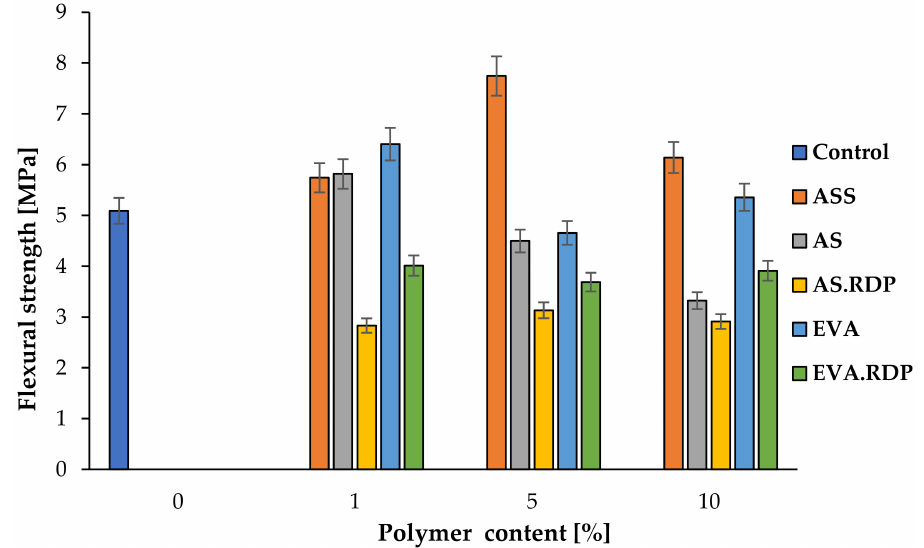
Figure 14. Flexural strength of the specimens with polymer